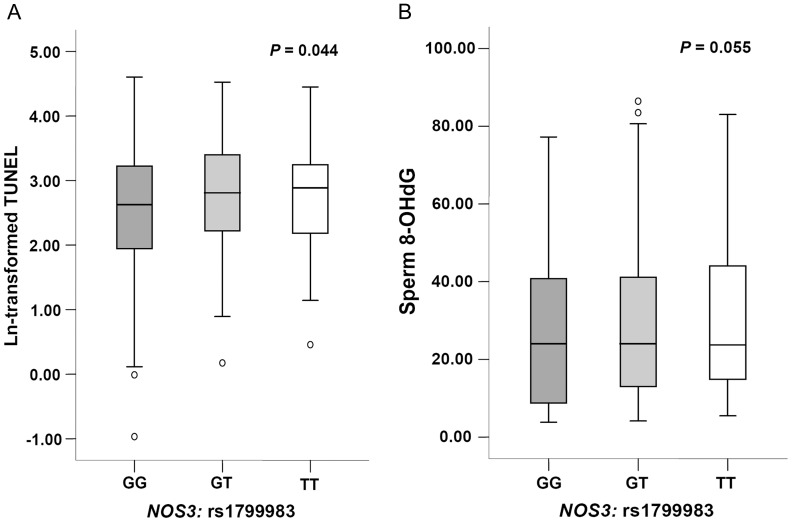
Box-and-whisker plots for sperm DNA damage levels in study subjects.The boxes represent the 25th and 75th percentiles; whiskers are lines extending from each end of the box covering the extent of the data on 1.5× inter-quartile range. The median value is denoted as the line that bisects the boxes. Circles represent the outlier values.